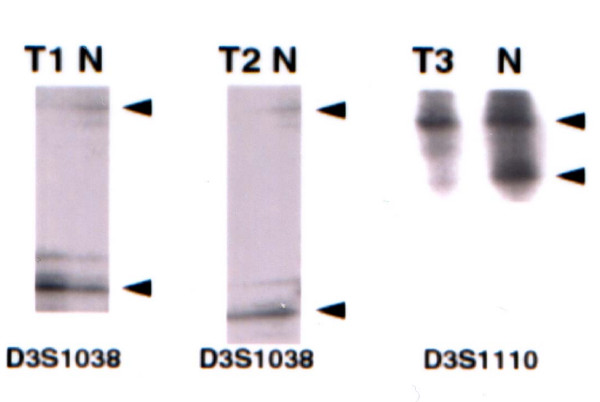
LOH analysis of the VHL gene locus of 3 cases of MEN 2A-related MTCs with marker D3S1038 or D3S1110. All cases show loss of one allele in microdissected tumor tissue (T), whereas heterozygosity is retained in normal non-neoplastic tissue (N). Arrows indicate the 2 VHL alleles.